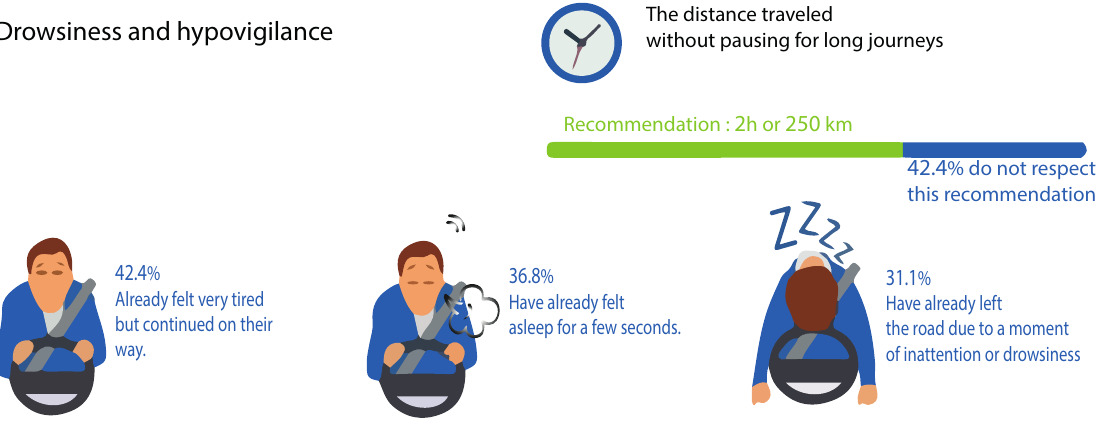
Figure 2. Study of prevalence and risk factors for drowsy driving in a Moroccan